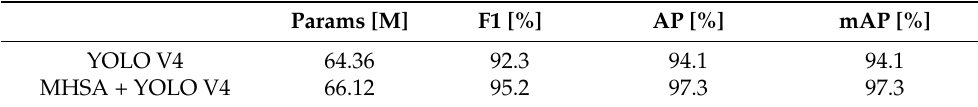
Table 3. Results of the ablation comparison experiment.